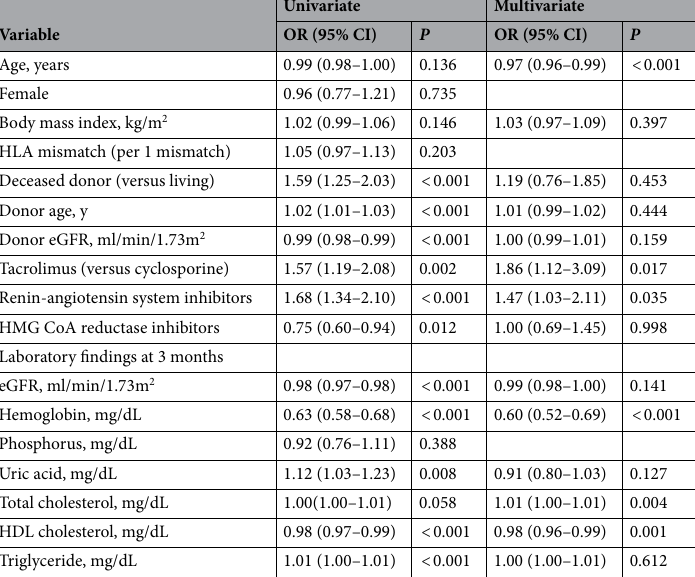
levels than in those with high levels. There were significant differences in the tacrolimus doses and trough levels, whereas there were no significant differences in the cyclosporine doses and trough levels among the groups. To confirm the risk factors associ- ated with low serum bilirubin levels, we performed multivariable logistic regression analyses using the lowest serum bilirubin quartile as a binary, dependent variable. In the multivariable analysis, recipient age, tacrolimus use, renin-angiotensin system inhibitor use, and hemoglobin, total cholesterol, and high-density lipoprotein cholesterol levels at 3 months post-transplantation remained associated with low serum bilirubin levels (Table 3). Serum bilirubin and graft outcomes. As shown in Fig. 3A, overall graft survival was significantly impaired with decreasing serum bilirubin levels ( P < 0.001). The 10-year graft survival rates were 91.5% in the highest quartile (Q4), 89.8% in the second quartile (Q3), 84.5% in the third quartile (Q2), and 76.8% in the lowest quartile (Q1; P < 0.001). Death-censored graft survival was also significantly different among the groups (Fig. 3B). Recipients with high bilirubin levels had the best death-censored graft survival, whereas recipients with low bilirubin levels had the worst death-censored graft survival. Compared with the highest bilirubin group, the lowest and third quartile groups were significantly associated with graft loss and death-censored graft failure (Table 4). The risks for graft loss and death-censored graft failure in the lowest bilirubin group remained significant, although attenuated, in the fully adjusted model (hazard ratio [HR] 2.64; 95% confidence interval [CI] 1.67–4.18; and HR 2.96; 95% CI 1.62–5.40, respectively). During follow-up, 66 (4.1%) patients died, including 34 who died of infectious causes, 12 who died of malig- nancies, 7 who died of cardiovascular causes, and 13 who died of other causes. Compared with the highest bilirubin group, the lowest bilirubin group was significantly associated with all-cause mortality (Fig. 3C). A multivariable Cox regression confirmed that the lowest serum bilirubin group was independently associated with higher mortality (HR, 2.07; 95% CI, 1.01–4.22). Serum bilirubin levels and graft rejection. During the follow-up period, 769 rejection episodes occurred in 286 patients (294 early-onset and 475 late-onset rejection episodes). The incidences of early-onset rejection (within 3 months from transplant) in Q1, Q2, Q3, and Q4, were 12.1%, 7.3%, 6.1%, and 4.0%, respec- tively ( P < 0.001). The ten-year cumulative probabilities for late-onset rejection (> 3 months after transplant), in Q1, Q2, Q3, and Q4, were 28.6%, 26.0%, 17.1%, and 16.4%, respectively (Fig. 4, P < 0.001). A greater proportion of patients in the Q1 and Q2 groups (9.4% and 9.7%, respectively) experienced multiple late-onset rejection episodes compared with those in the Q3 and Q4 groups (6.1% and 4.0%, respectively; P < 0.001). Serum bilirubin and graft renal function. The mean estimated glomerular filtration rate (eGFR) was consistently lower in the lowest bilirubin (Q1) and third quartile groups (Q2) than in the highest bilirubin (Q4) and second quartile groups (Q3), throughout the follow-up period (Fig. 5). The mean eGFRs at 5-years post-transplantation were 63.5 ± 22.5, 68.2 ± 21.0, 71.4 ± 19.7, and 70.5 ± 18.7 mL/min/1.73 m 2 , respectively ( P < 0.001). The significant effects of serum bilirubin on graft function were maintained, regardless of donor status (data not shown).